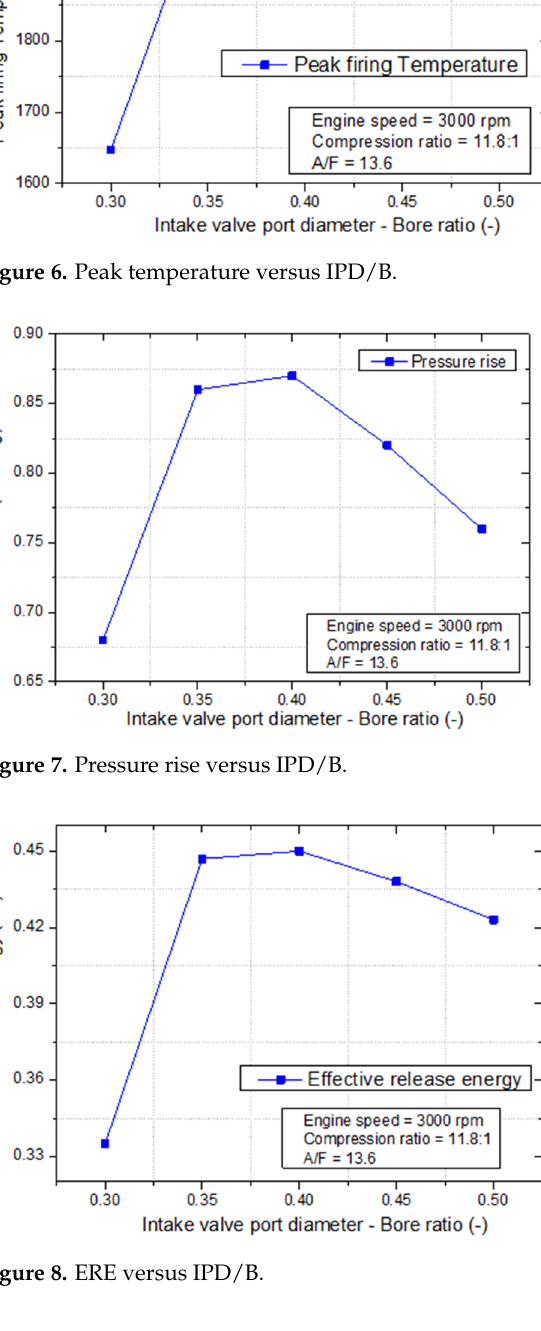
Figure 9. IMEP versus IPD/B.